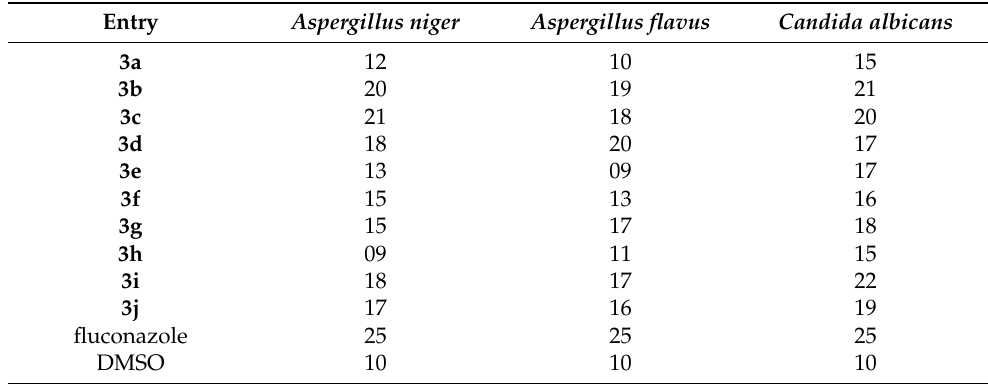
Table 6. Antifungal activity of benzimidazole